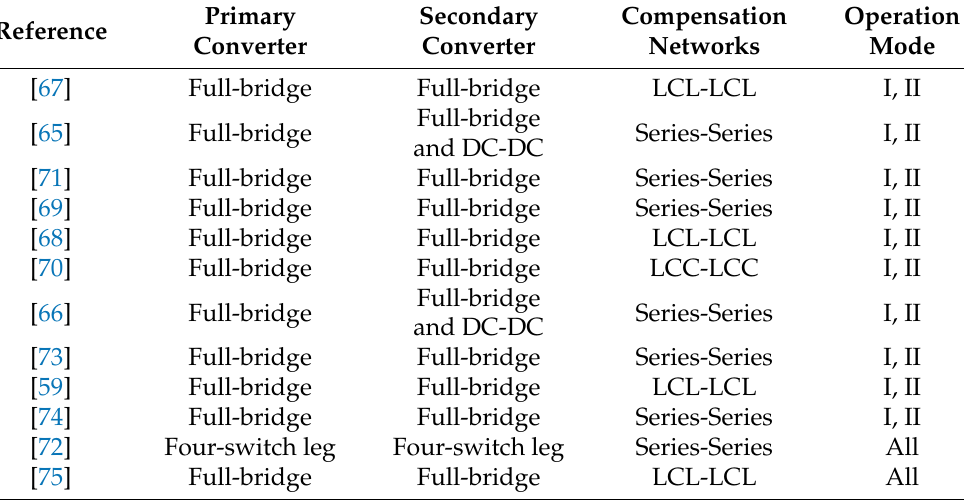
Table 2. Main features of V2G control based on the phase-delay between the power